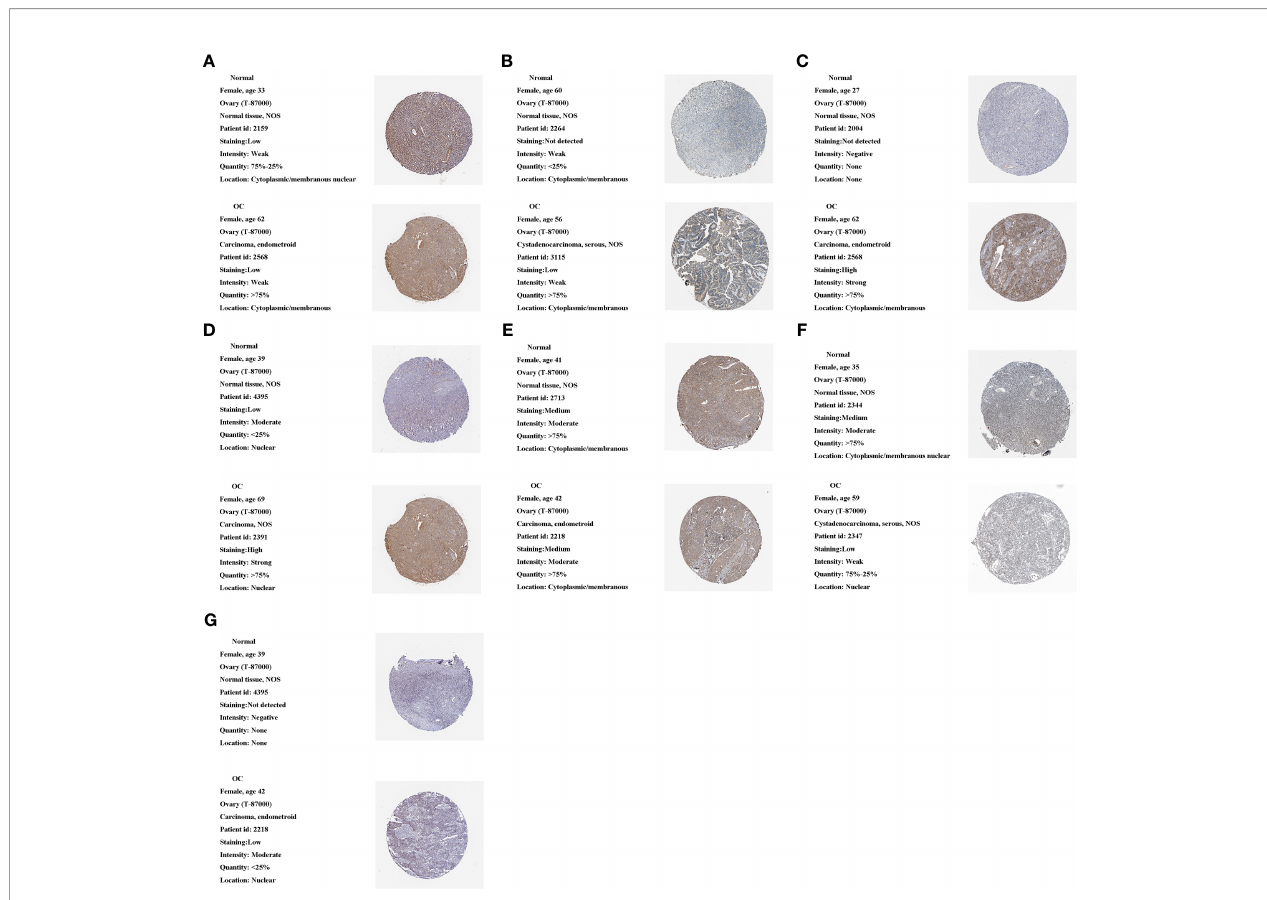
FIGURE 10 | Protein expression of 10 m1A regulators in the tumor and normal tissues in the HPA database. (A) ALKBH1 expression. (B) ALKBH3 expression. (C) TRMT10C expression. (D) TRMT6 expression. (E) TRMT61B expression. (F) YTHDC1 expression. (G) YTHDF2